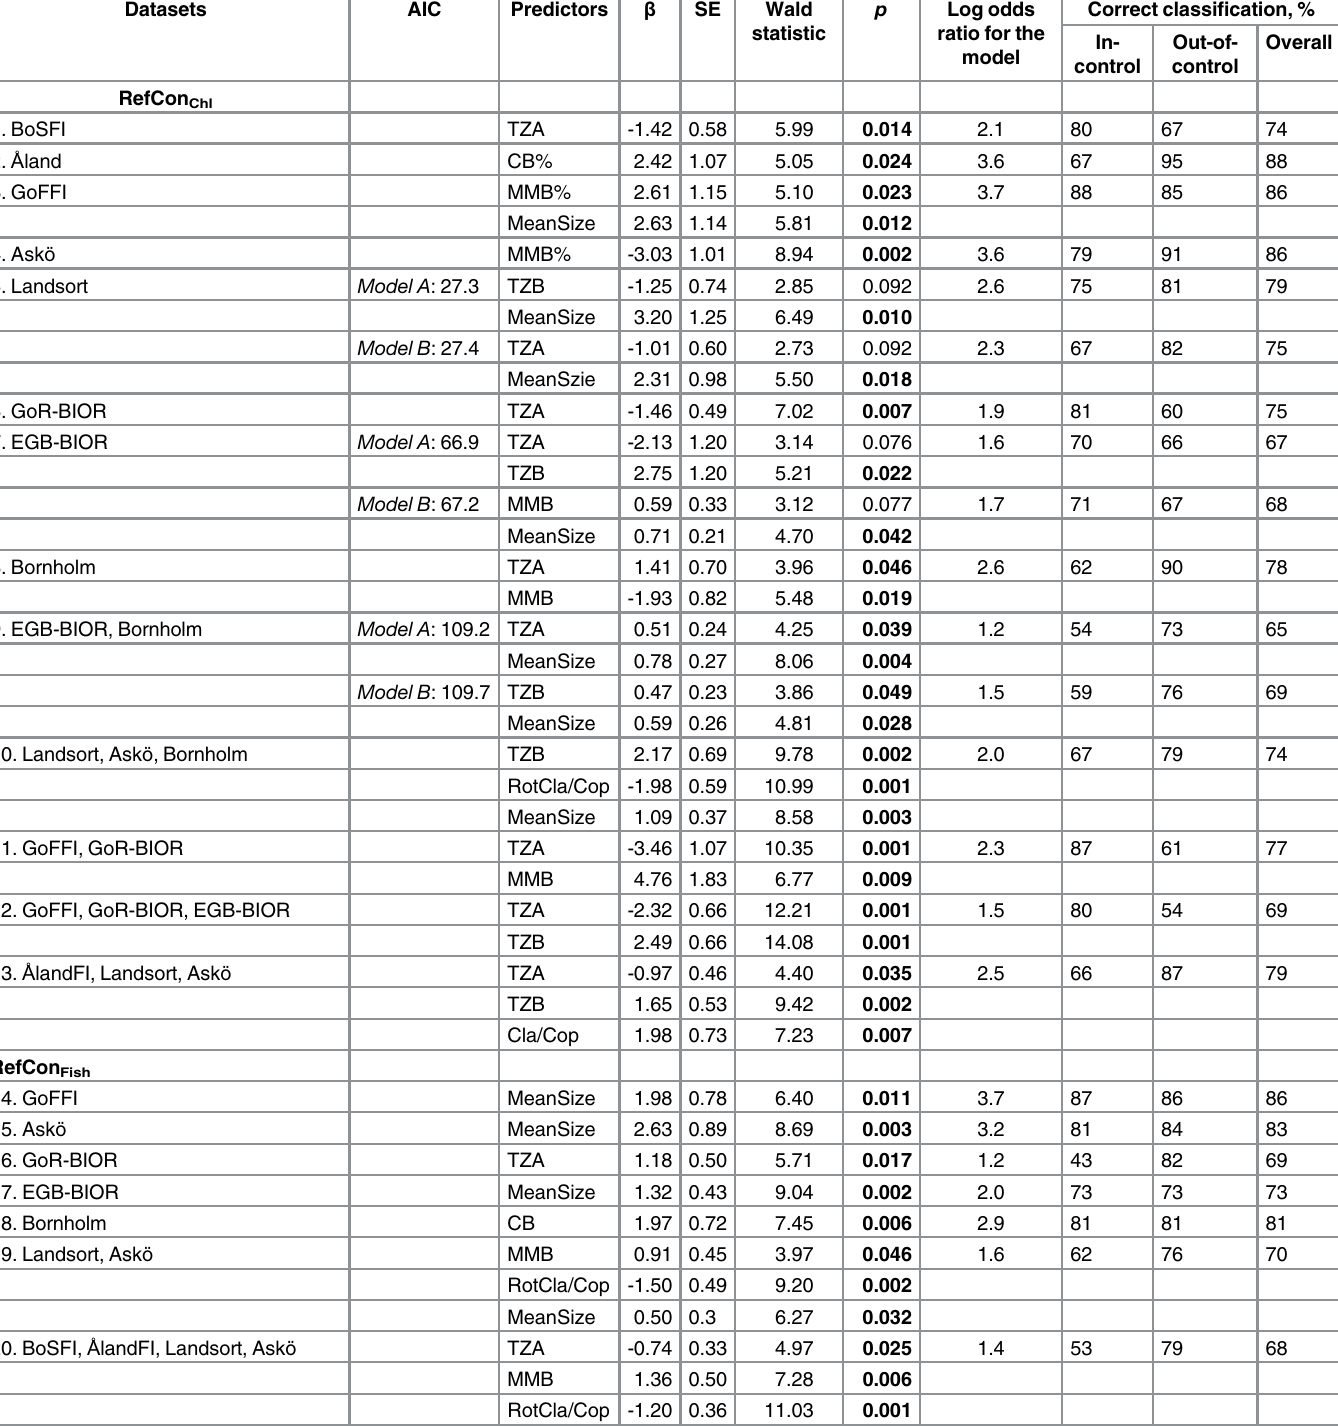
Table 5. Winning logistic models for prediction of zooplankton community structure being in the reference state for RefCon Chl and RefCon Fish . When equally strong models were found for the same dataset, their AIC values are provided. Only significant models are shown; significant effects are in bold. Correct classification percentage and odds ratio are used for model accuracy